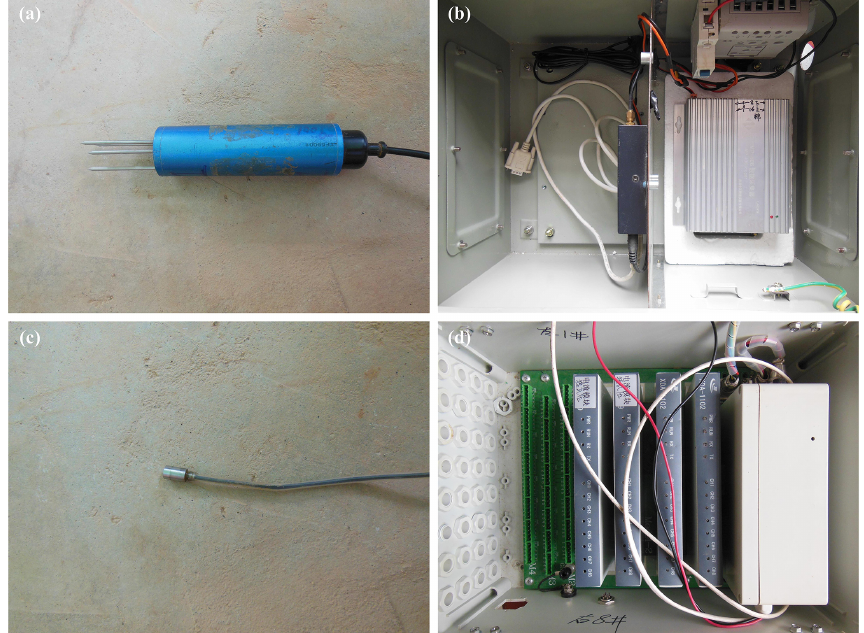
Figure 3. Testing equipments. (a) Soil moisture sensor (the model is MP-406B). (b) Soil moisture collector (the model is M-16). (c) Micro gauge of pore water pressure (the model is HC-25). (d) Pore water pressure collector (the model is MCU).